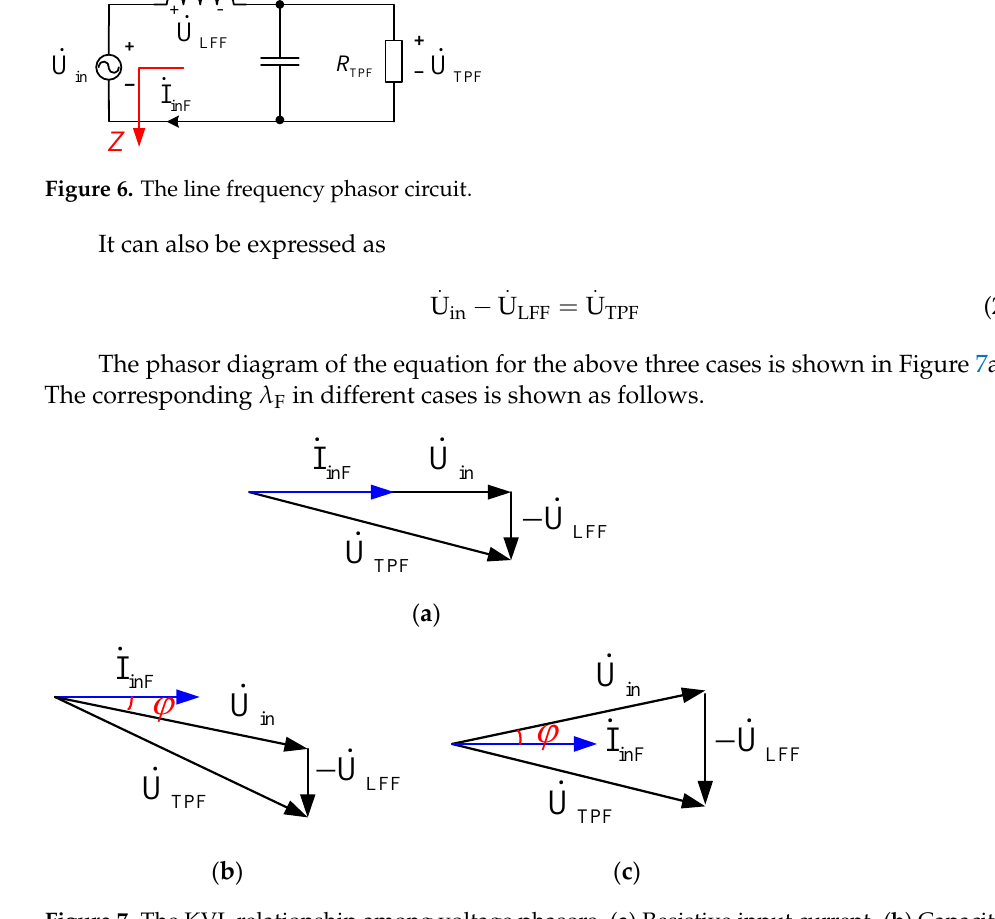
Figure 7. The KVL relationship among voltage phasors. ( a ) Resistive input current. ( b ) Capacitive input current. ( c ) Inductive input current.